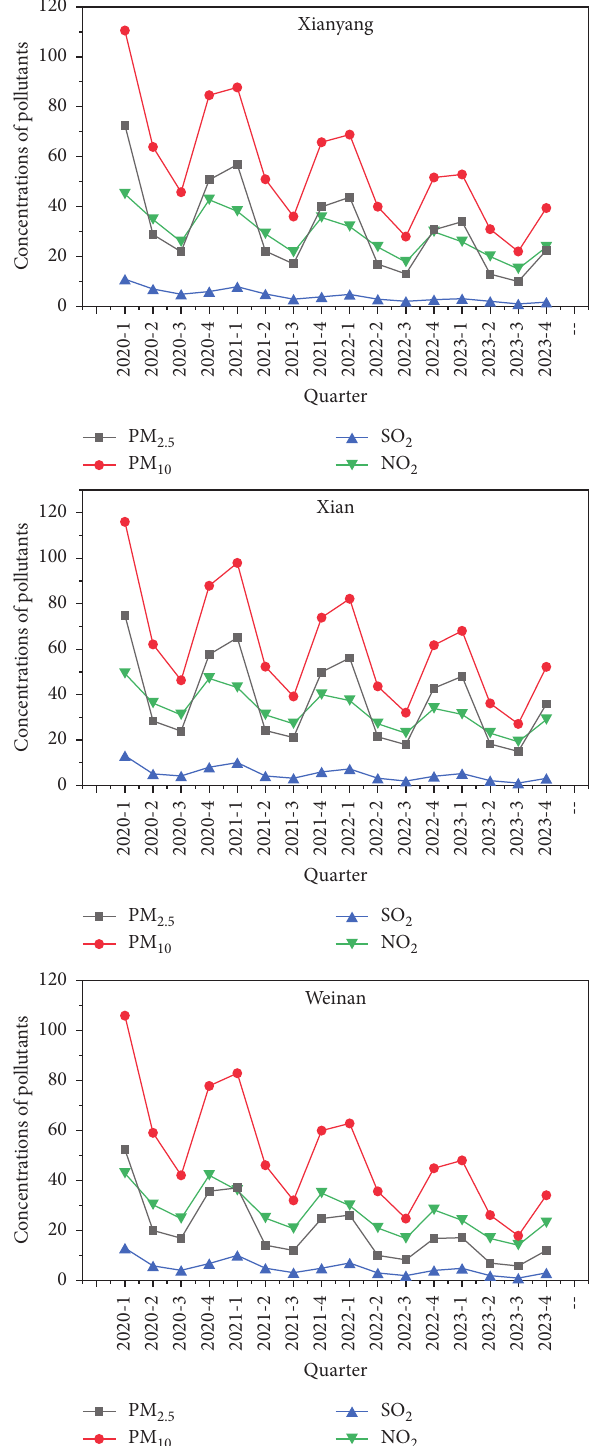
Figure 7: The predicted concentrations of four pollutants in three cities in Shaanxi